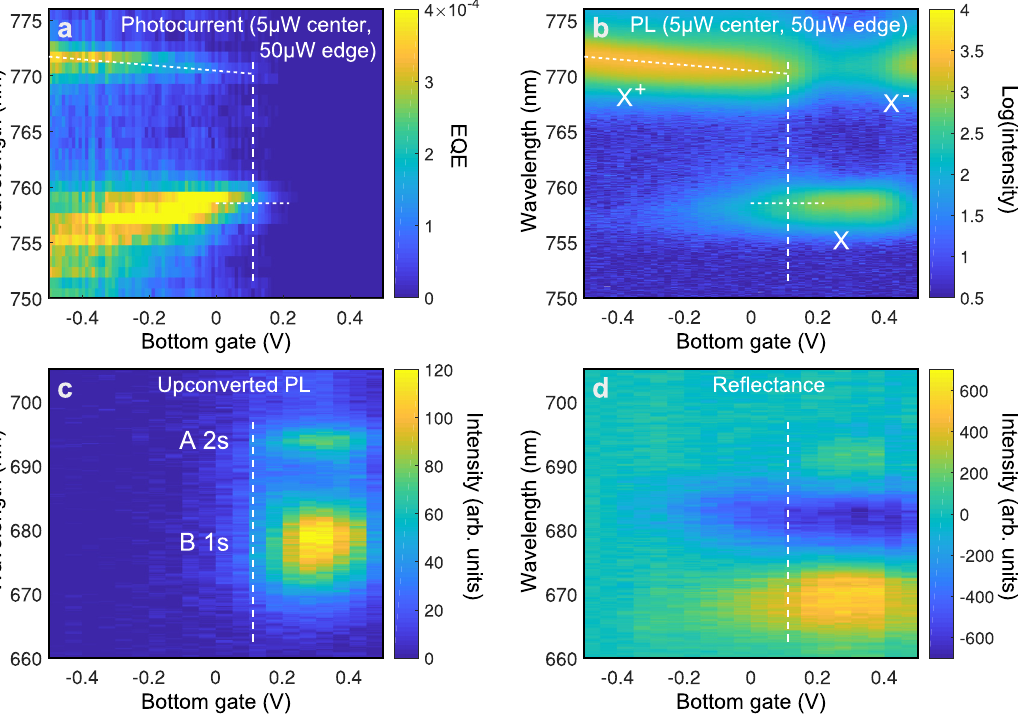
Figure 5: Photocurrent under resonant excitation and competition with exciton upconversion. a) MoSe 2 (device C) photocurrent differential for 50 µW off-resonant gate-edge excitation and 5 µW variable-wavelength center excitation shows current following the exciton and trion resonances seen in photoluminescence (PL) in (b). c) Upconverted photoluminescence spectra taken at 759 nm excitation, documented in literature to arise from Auger excitation of the 1s A exciton, yielding emission of higher Rydberg states,alongwiththeBexciton.d)Re fl ectancespectraindicatingthattheBexcitonstatepersistsinthehole-dopedregime.Theonsetofhole- doping,however,correspondstoalossofphotoluminescencefromtheBexcitonstateandacorrespondingonsetofphotocurrent,suggesting a competition between exciton – exciton Auger and exciton – hole Auger, with the latter dominating in the doped